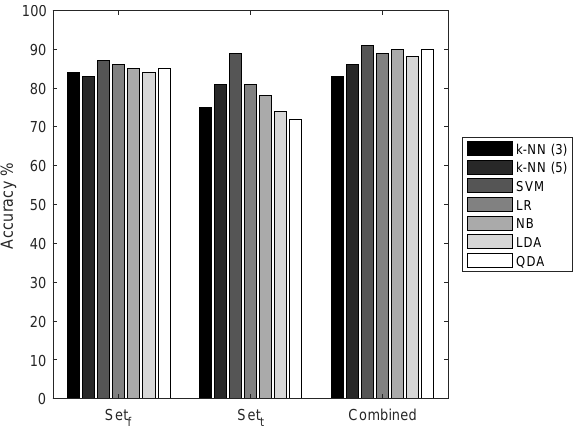
Figure 5. Performance of classifiers for different sets of